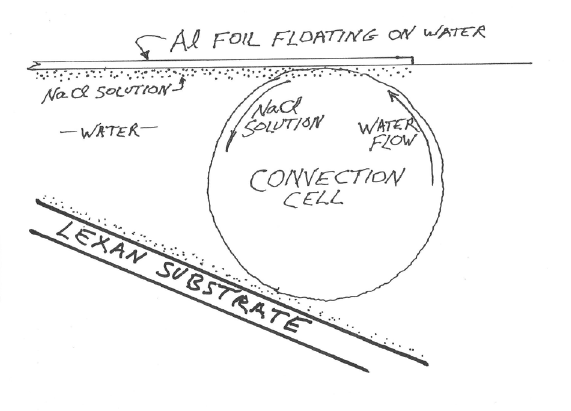
Fig. 5: Convection in a parting-agent-water system. The target maker detected this occurrence by sudden motions of the foil floating on the top of the bath; the foil was sufficiently frail that these motions resulted in the crumpling, wrinkling, and/or tearing of the foil (Fig. 6).